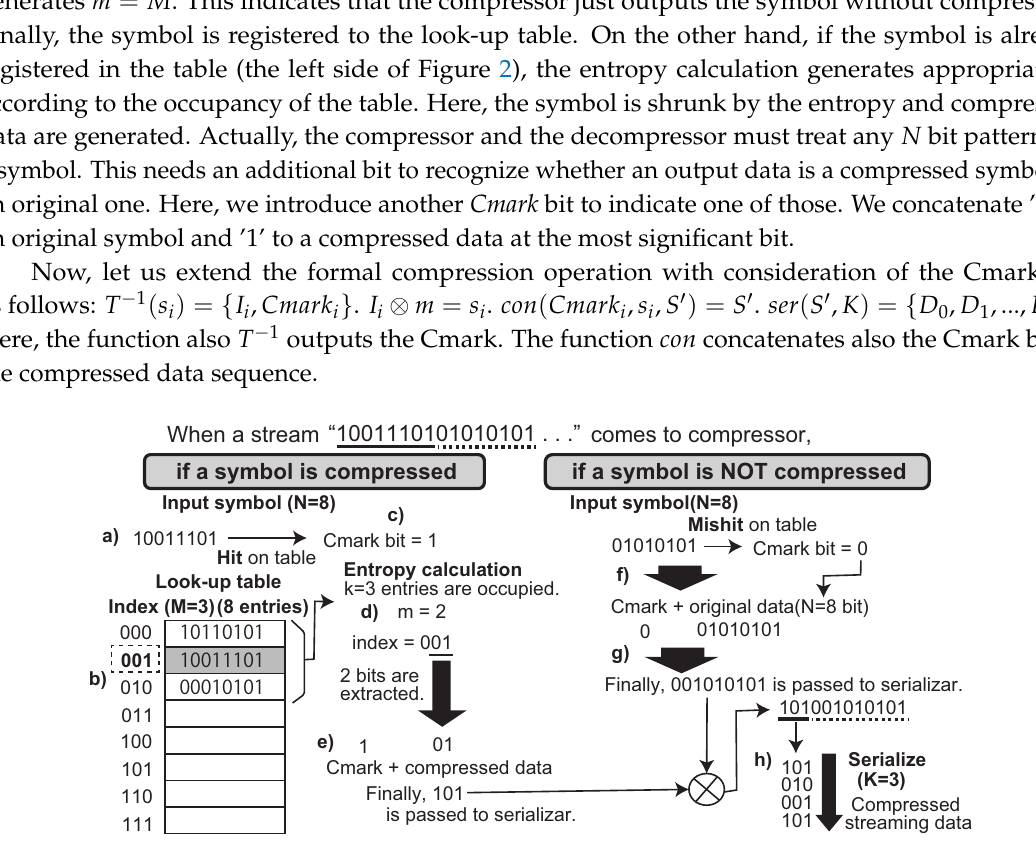
Figure 2. Compression mechanism in ASE coding. When an original symbol is compressed, as shown in the left side, ( a ) the first eight bits are picked up as the symbol, and ( b ) the symbol is matched in the look-up table. Because M is 3, the index is selected in three bits. To indicate the symbol is compressed, ( c ) Cmark bit is set. After the entropy calculation generates 2, ( d ) the selected table index is shrunk to two bits and treated as a compressed data. ( e ) The Cmark is merged in the MSB with the compressed data. Besides, when a symbol is not compressed as shown in the right side, because the symbol does not match to any entry in the look-up table, ( f ) the Cmark bit is reset. Subsequently, ( g ) the Cmark bit is merged in the MSB with the original symbol. Finally, ( h ) the serializer concatenates all data resulted from the operations above, and aligns to three bits. The aligned data stream is outputted from the